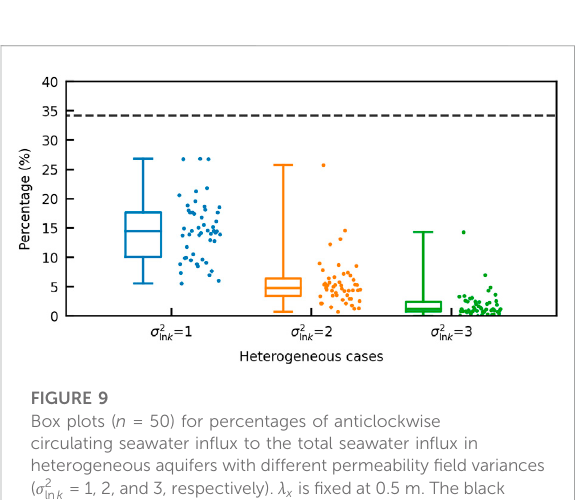
FIGURE 9 Box plots ( n = 50) for percentages of anticlockwise circulating seawater in fl ux to the total seawater in fl ux in heterogeneous aquifers with different permeability fi eld variances ( σ 2 ln k = 1, 2, and 3, respectively). λ x is fi xed at 0.5 m. The black dashed line is the result for the homogeneous